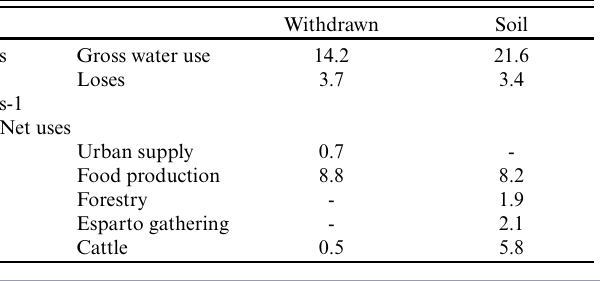
Table 6 . Annual water uses in the Upper Andarax (Hm³).